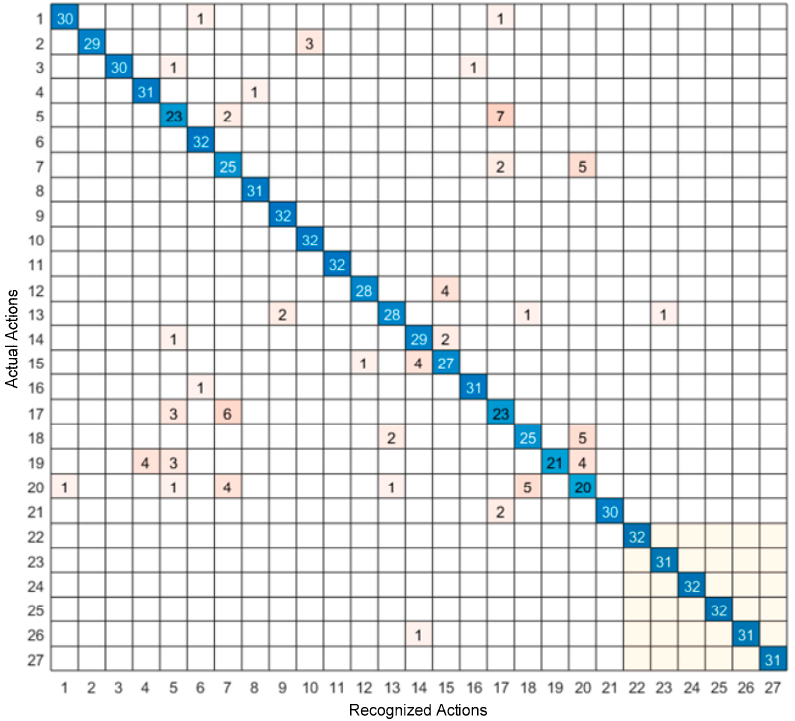
Figure 7. Confusion matrix of the inertial only sensing modality.